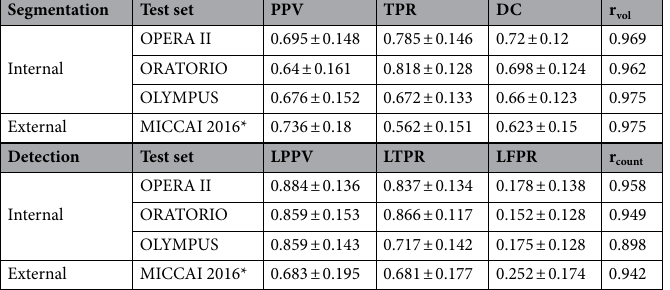
Table 2. Segmentation and lesion detection performance of the multi-arm U-Net on internal and external test sets. Means ± standard deviations reported. r vol Pearson correlation coefficient of predicted and ground truth (GT) total lesion volumes, r count Pearson correlation coefficient of predicted and ground truth total lesion counts. *Performance metrics were estimated using the consensus mask as the